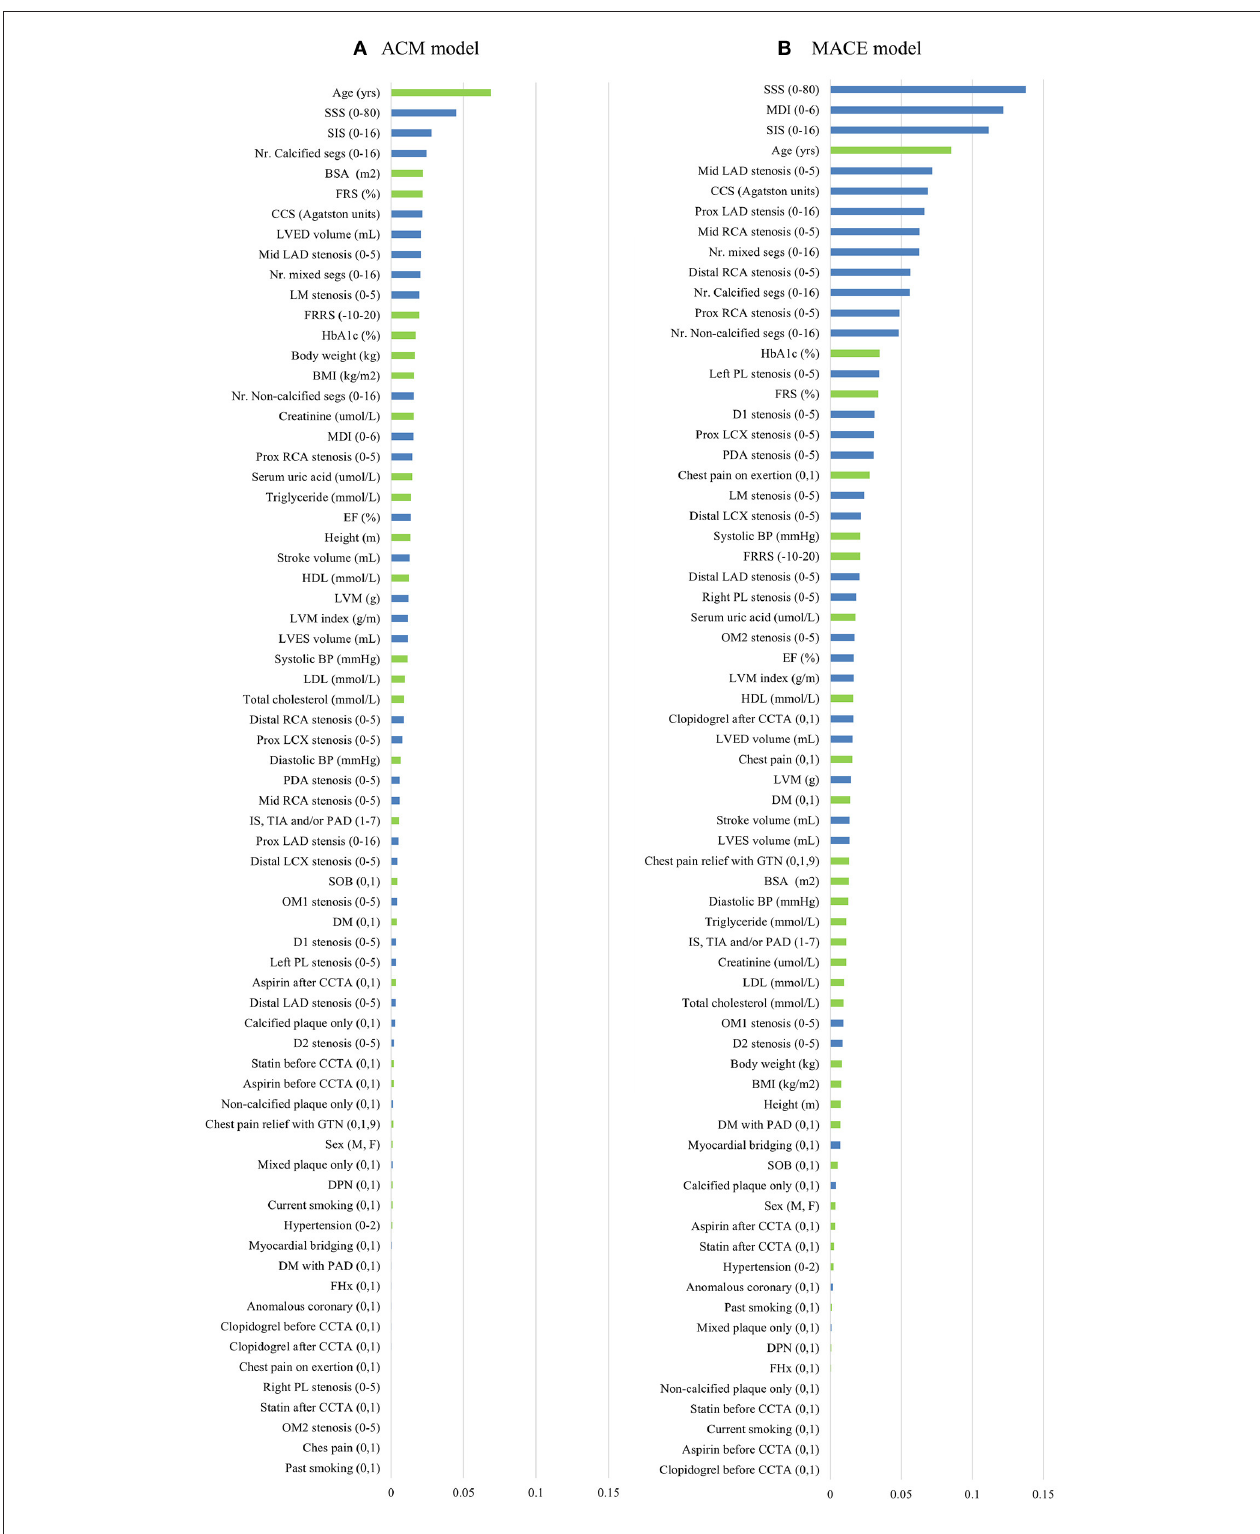
FIGURE 3 | Feature selection of two models. Thirty-five CT angiography metrics (blue) and 34 clinical variables (green) were available. The information gain ranking was to evaluate the relevance of an attribute with the prediction of the training data. Four different methods of information gain ranking were used for each model.